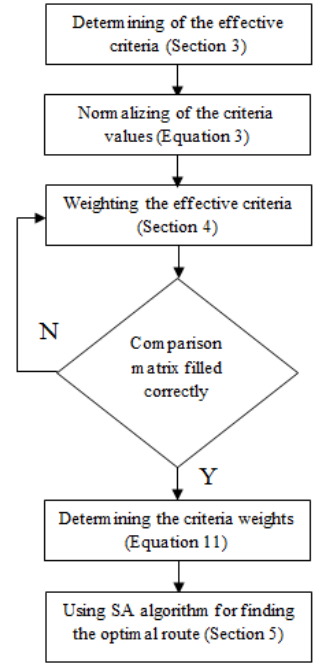
Figure 1. The flow chart of the proposed